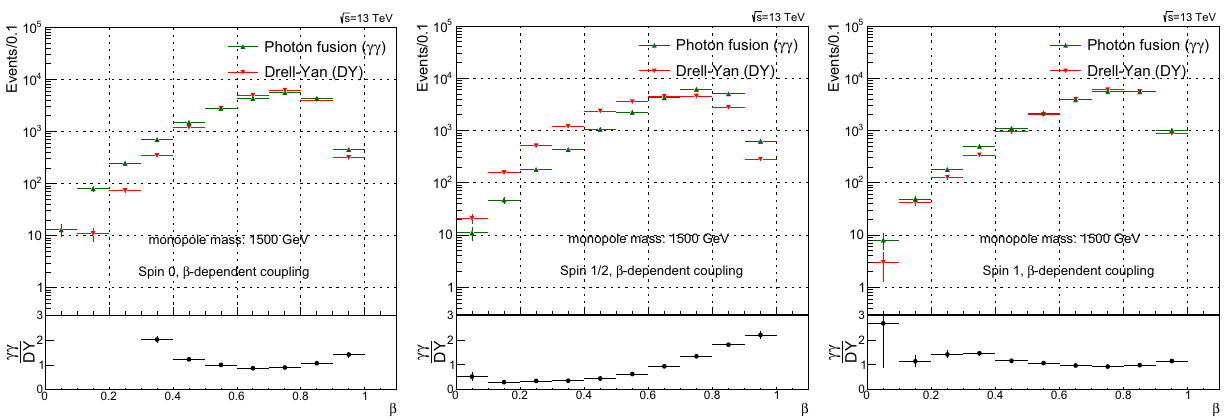
Fig. 22 The monopole velocity β distributions of spin-0 (left), spin- 1 / 2 (centre) and spin-1 monopoles (right) for both the photon-fusion and the √ s = 13 TeV. The LUXqed and NNPDF23 PDFs were used for the PF and the DY process, respectively Drell–Yan mechanisms at